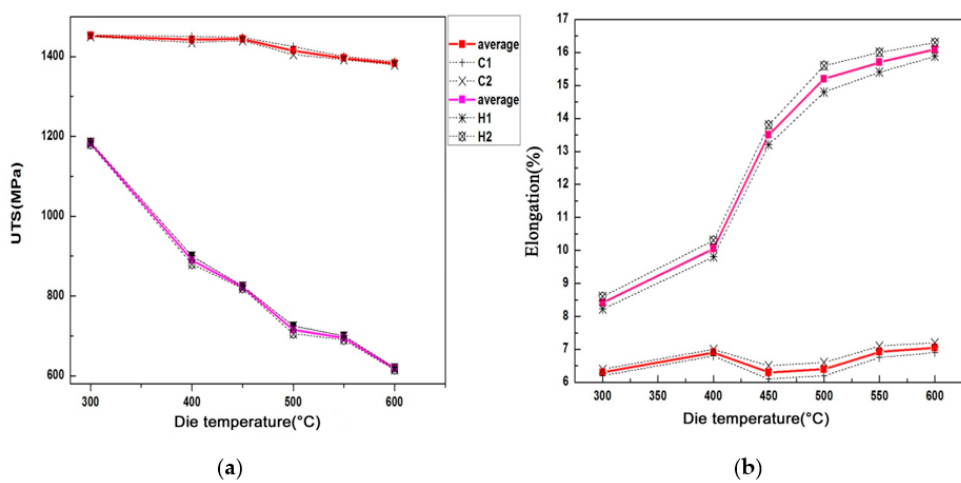
Figure 13. Hardness of different locations at different die temperatures.